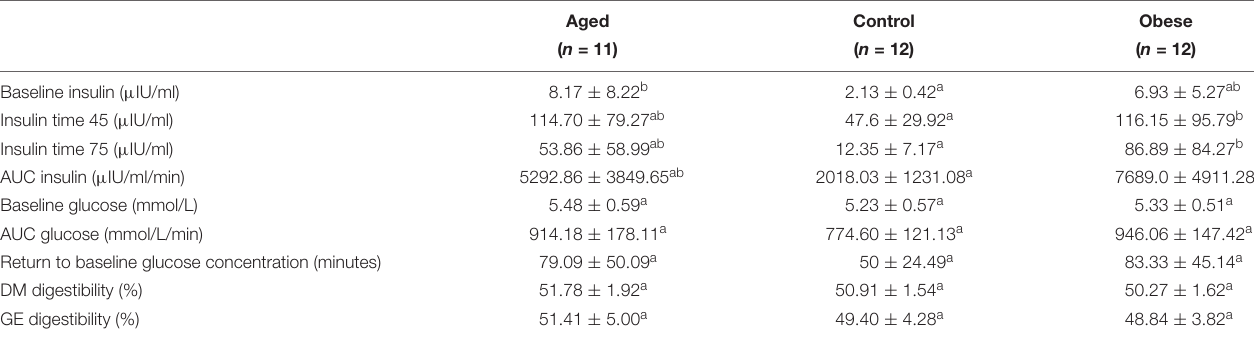
TABLE 2 | Combined glucose-insulin tolerance test and apparent digestibility parameters (mean ± SD) for animals in the three phenotypic groups.